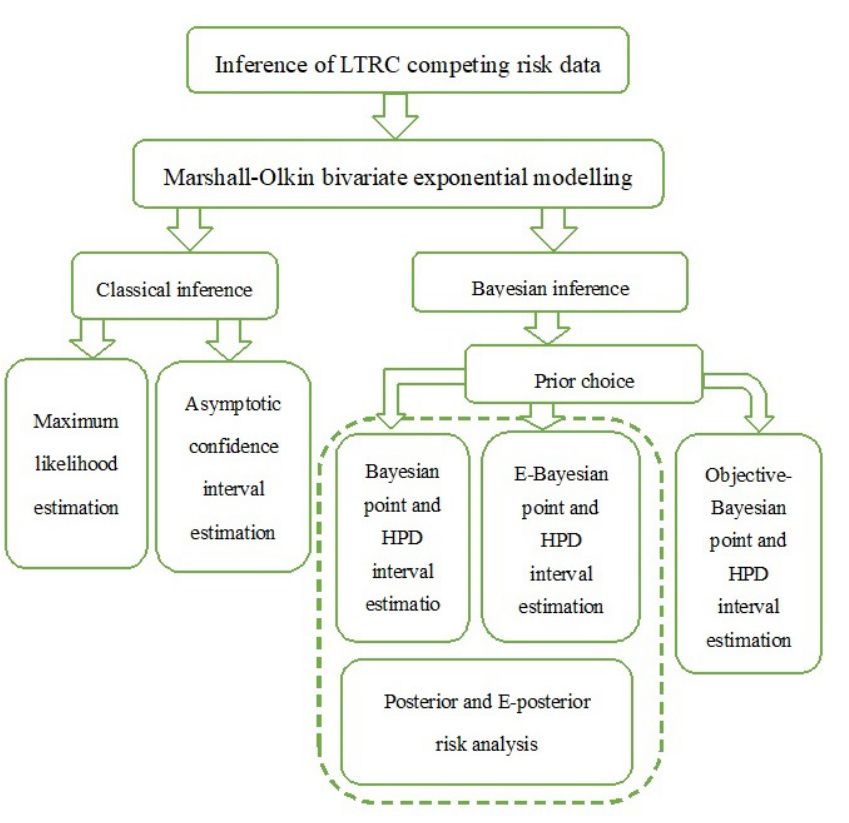
Figure 2. Flowchart of the main contents in this